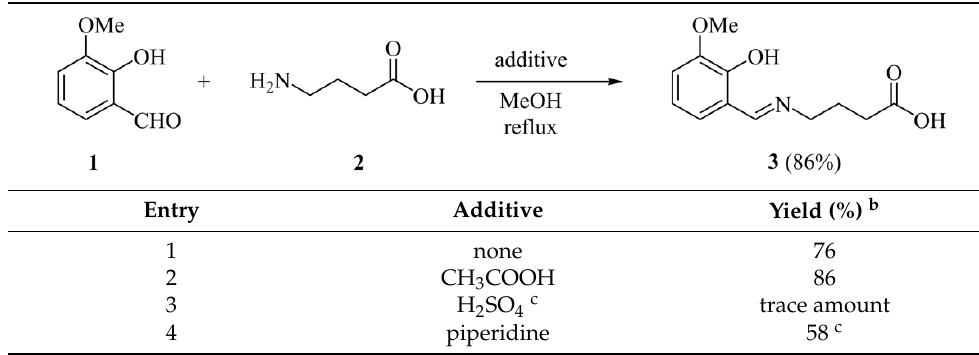
Table 1. Optimization of the reaction conditions regarding the additive a .